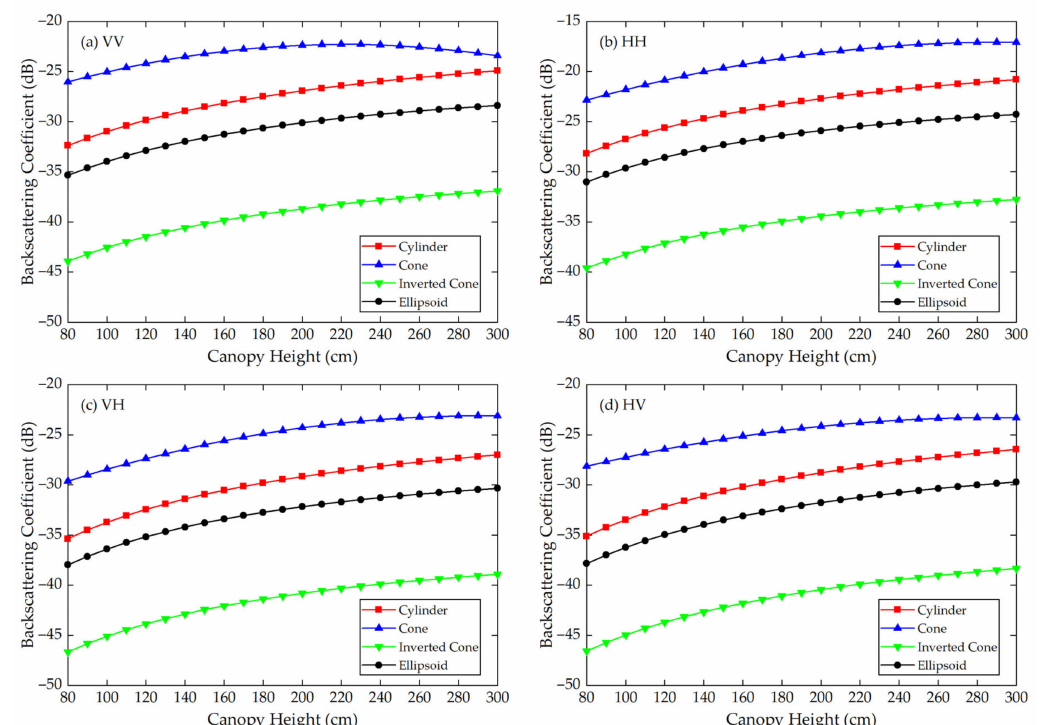
Figure 9. The MTVM simulation results of the backscattering coefficients for different crown shapes in X band (9.6 GHz) at